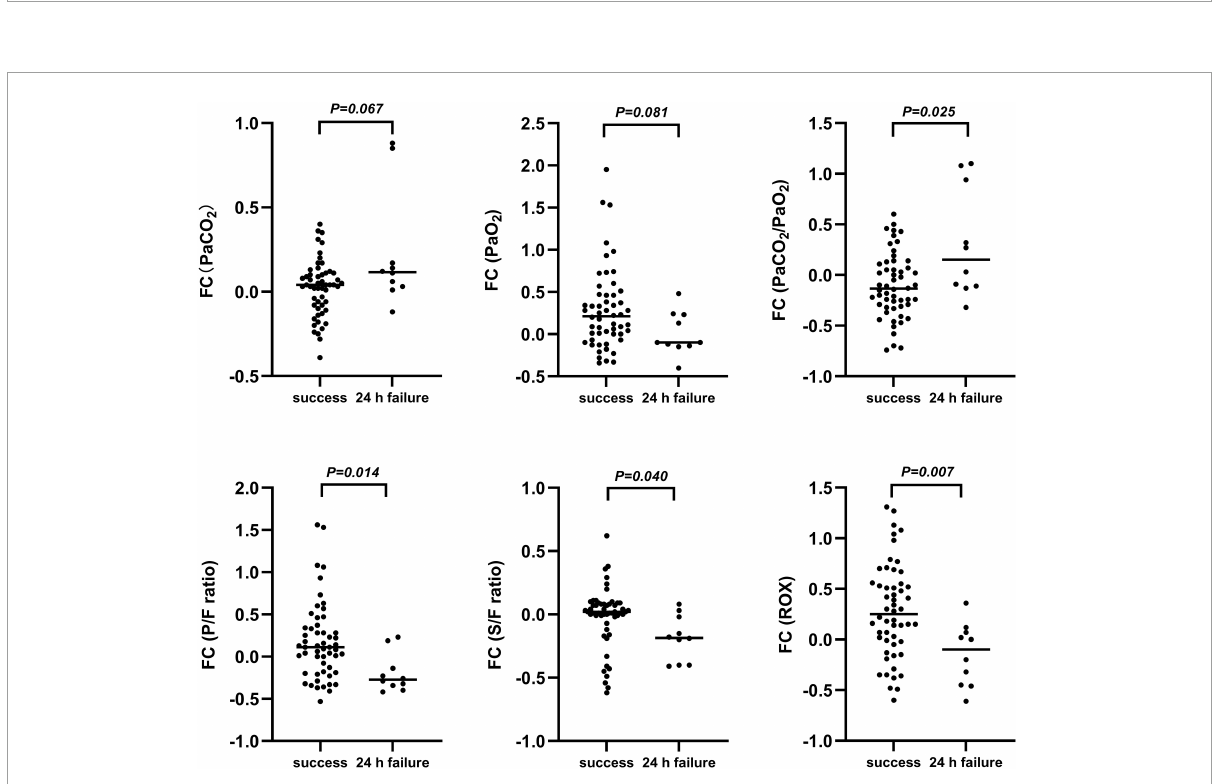
FIGURE4 Fractional changes in blood gas indexes prior to treatment and up to 2 h post-treatment. FC, Fractional change = (data 2 h after HFNC treatment)-(data before HFNC treatment)/data before HFNC treatment; PaCO 2 , arterial partial pressure of carbon dioxide; PaO 2 , arterial partial pressure of oxygen; PaCO 2 /PaO 2 , arterial partial pressure of carbon dioxide-to-arterial partial pressure of oxygen; P/F ratio, arterial partial oxygen pressure-to-fraction of inspired oxygen ratio; S/F ratio, percutaneous oxygen saturation-to-fraction of inspired oxygen ratio; ROX, ratio of percutaneous oxygen saturation and fraction of inspired oxygen to respiratory